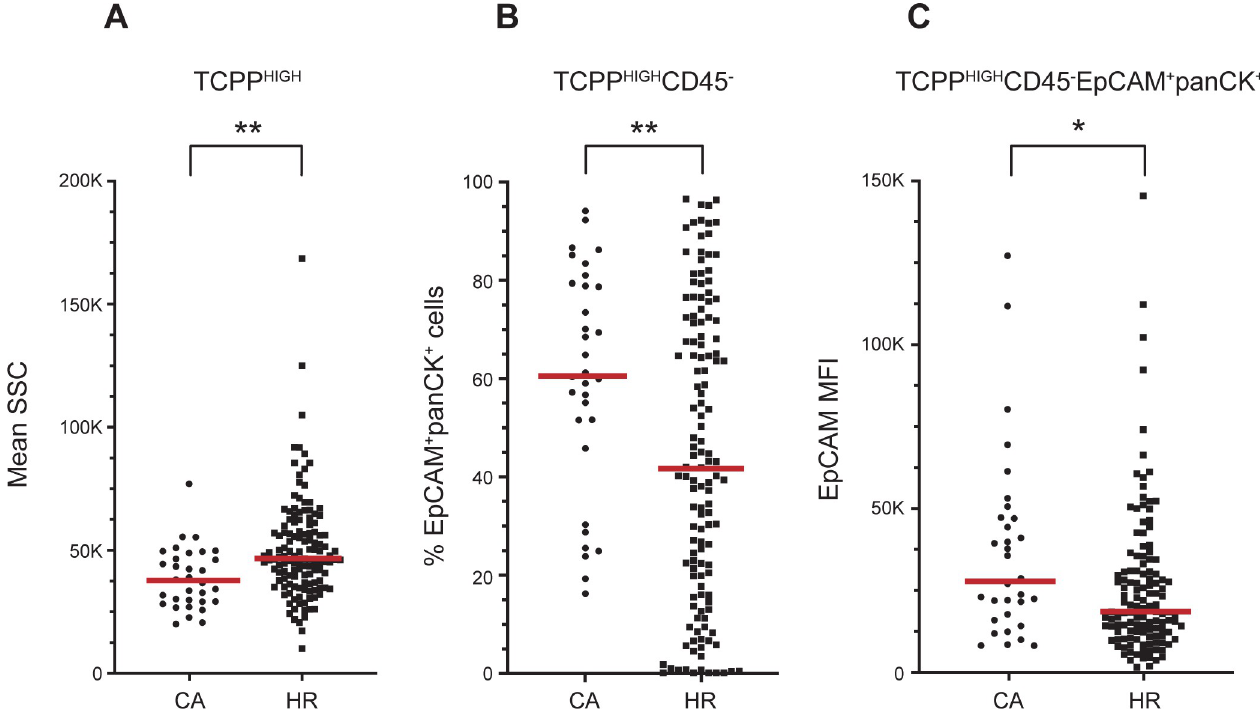
Fig 7. Differences in sputum cell characteristics between cancer and high-risk sputum samples. Depicted are the significant differences between cancer (CA; n = 32) and high-risk samples (HR; n = 132) resulting from the analysis described in Fig 5. Each dot (CA) and square (HR) represent one sample. A ) the TCPP HIGH population in cancer samples displays a smaller SSC than the TCPP HIGH population in high-risk samples ( �� p < 0.01). B ) In cancer samples, the proportion of EpCAM + panCK + cells in the CD45 - fraction of the TCPP HIGH subpopulation is larger than in the corresponding CD45 - fraction in high-risk samples ( �� p < 0.01). C ) The mean fluorescence intensity (MFI) of EpCAM in TCPP HIGH CD45 - EpCAM + panCK + cells is higher in cancer samples than in the corresponding cellular subset of high-risk samples ( � p < 0.05). The red lines indicate the median values for each sample